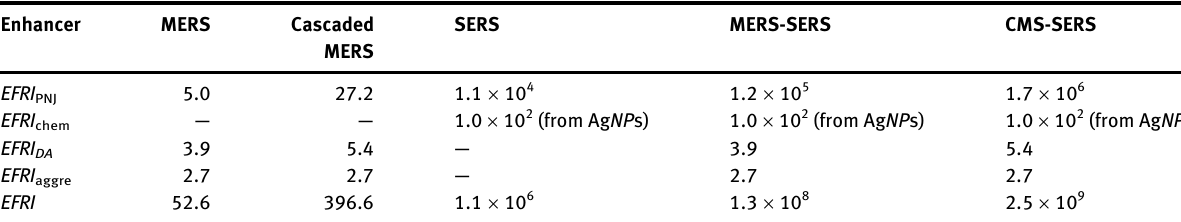
Table  : Theoretical calculations of EFRI for various Raman enhancers.